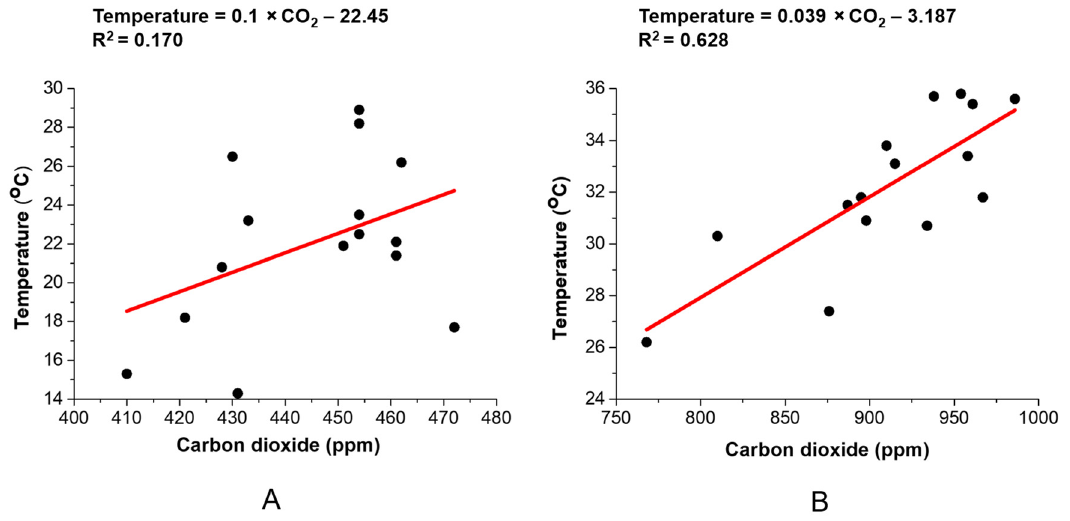
Figure 12. The relationships between CO 2 concentration and air temperature inside the greenhouse during the WCS condition ( A ) and CS condition ( B ) in the experimental periods. The regression analysis of the average data of CO 2 and temperature was recorded in three different layers in the experimental greenhouse.